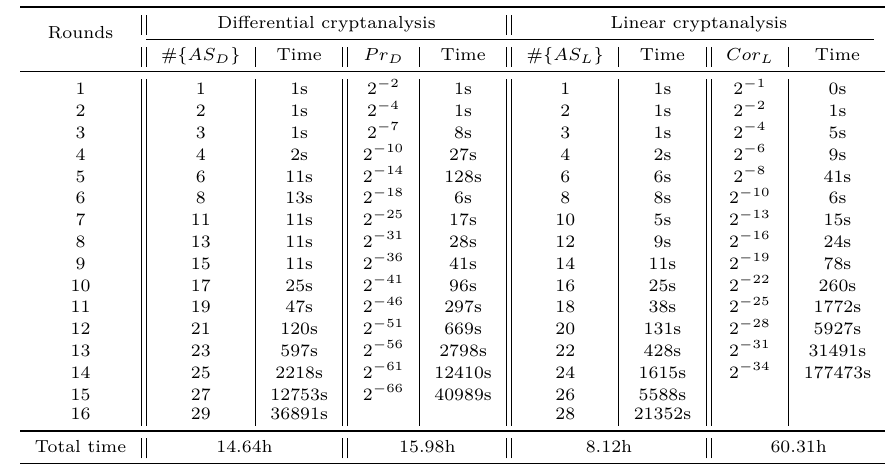
Table 4: Experimental results of